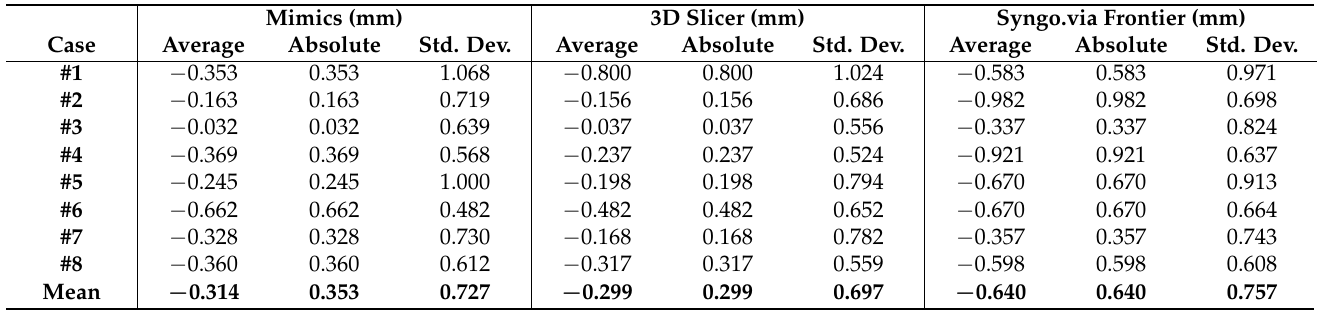
Table 2. Signed Euclidean distance: average, absolute, and standard deviation between the